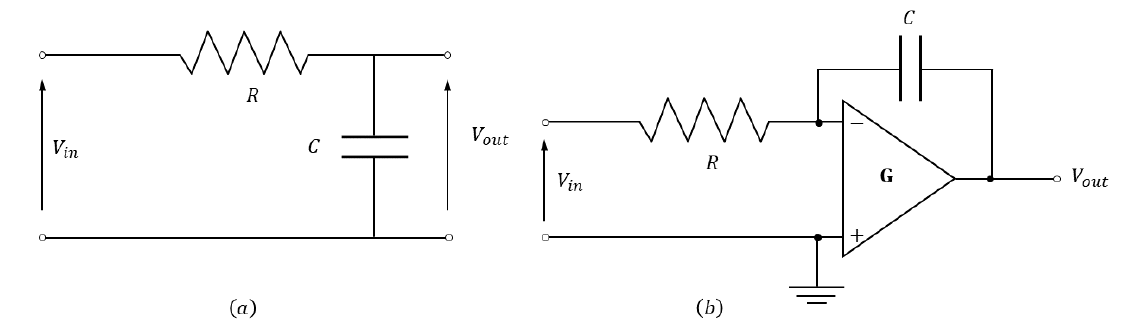
Figure 8. Passive ( a ) and active ( b ) integrator circuits. The active circuit uses an operational amplifier with gain